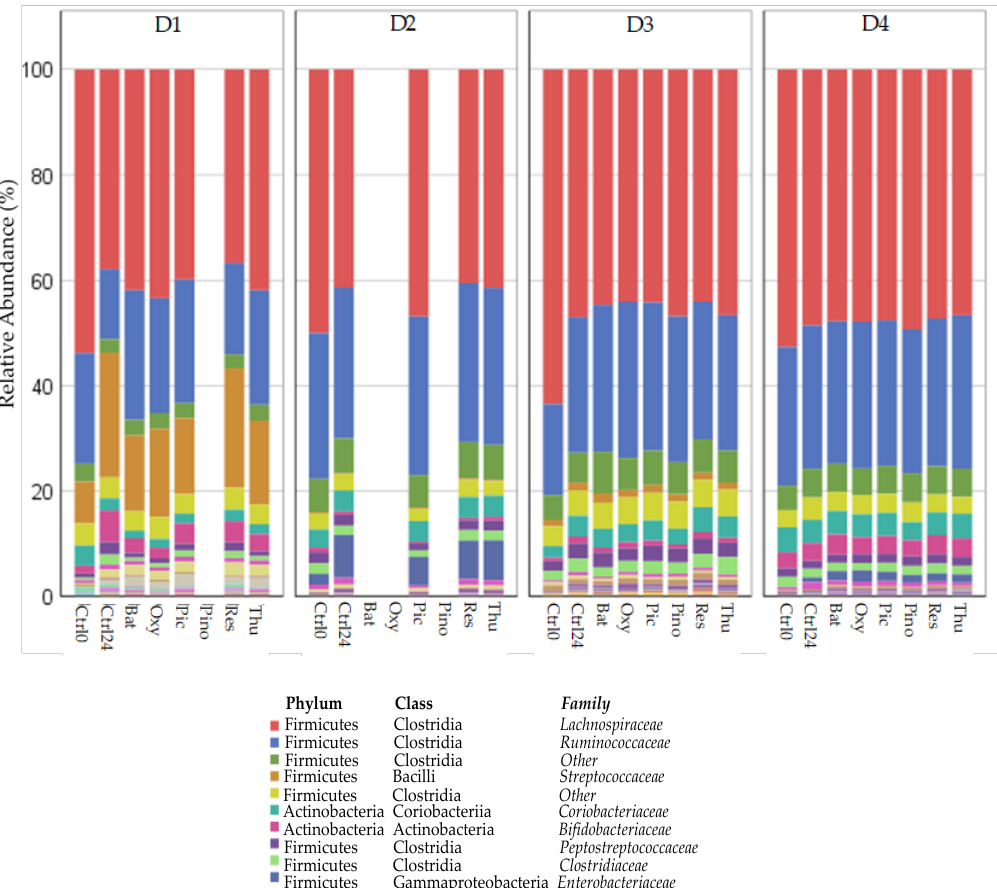
Figure A2. Bacterial composition at the family level, per donor, for the 10 most abundant taxa. D# denotes the donor; Ctrl0, control at 0 h; Ctrl24, control at 24 h; Bat, batatasin III; Oxy, oxyresveratrol; Pic, piceatannol; Pino, pinostilbene; Res, trans-resveratrol; Thu, thunalbene (all stilbenoids at 24 h).